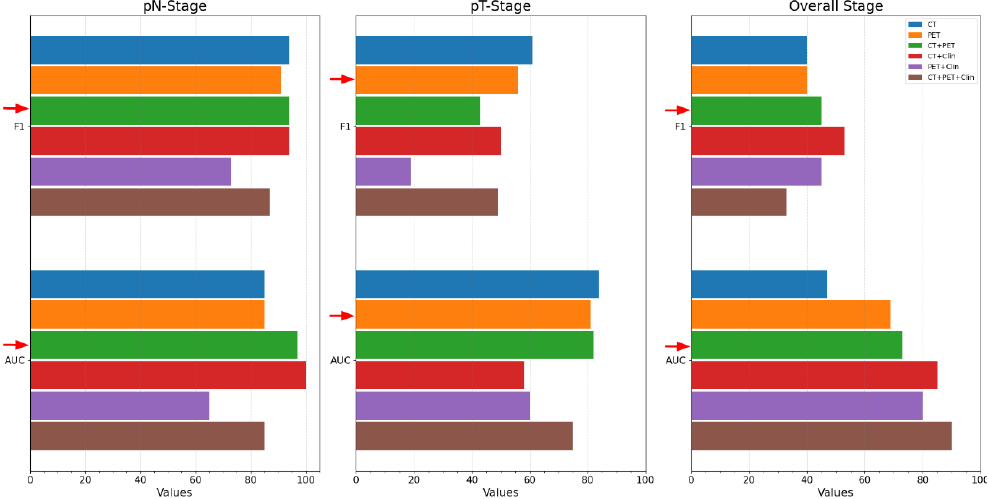
Figure 4. Radiomics features extracted from the original PET and CT images. The red arrows indicate the best results obtained by using the best model in terms of AUC for LOO-CV strategy on DS 1 . The bar-plot refers to all possible combinations between the features, to obtain higher classification performance (F1 score and AUC), relative to pN-Stage (7 features from CT images and 10 features from PET images), pT-Stage (5 features from PET images) and the Overall Stage (9 features from CT images and 19 features from PET images).